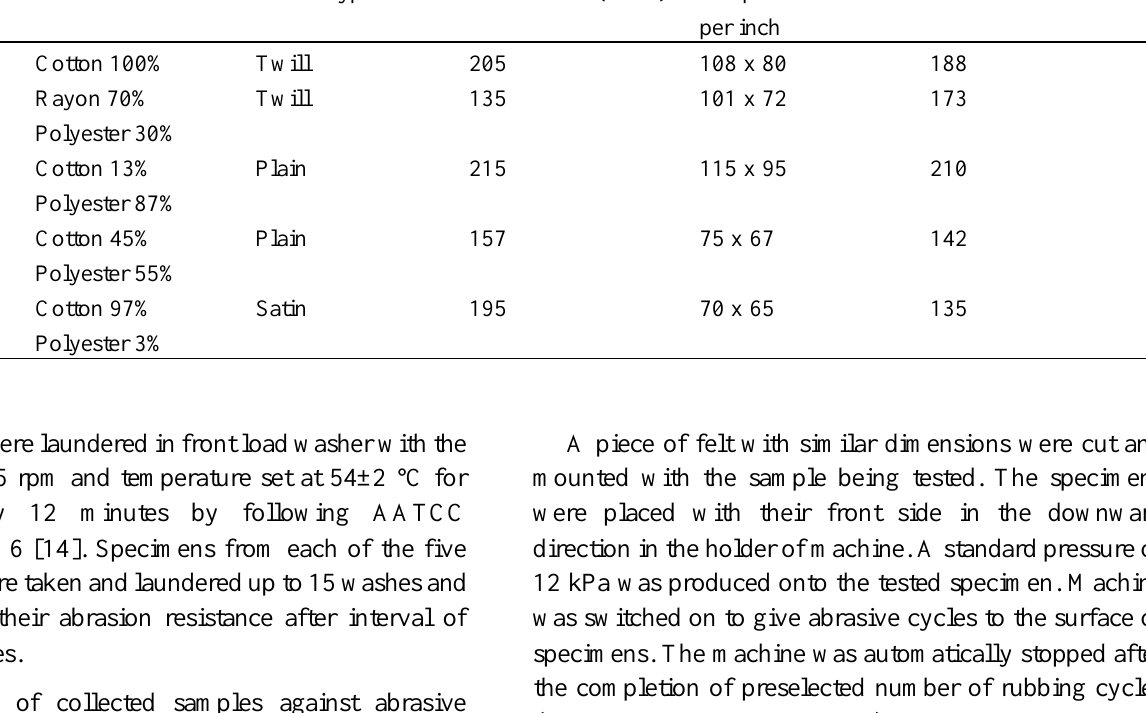
Construction parameters of collected upholstery fabrics Sample